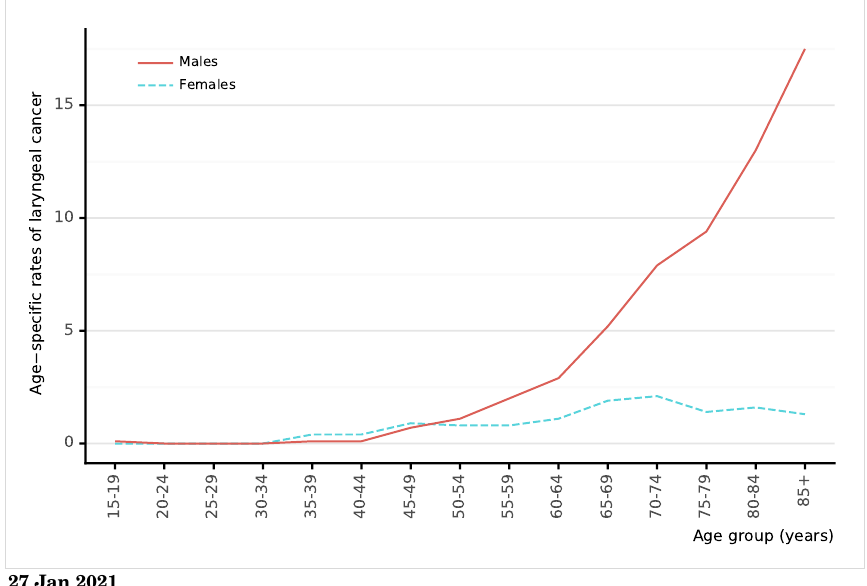
Figure 48: Age-specific incidence rates of laryngeal cancer in Peru (estimates for 2020)